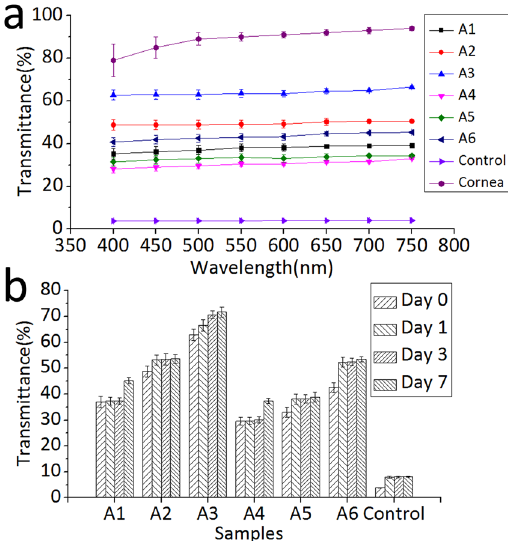
Figure 6. The transparency test results; ( a ) The average transmittance spectra of hybrid constructs A1-A6, the control group and the acellular pig cornea after incubating in PBS for 1 h (day 0); ( b ) Transmittance histogram of six hybrid constructs A1-A6 and the control after 0, 1, 3, and 7 days of immersion in PBS under the 500 nm